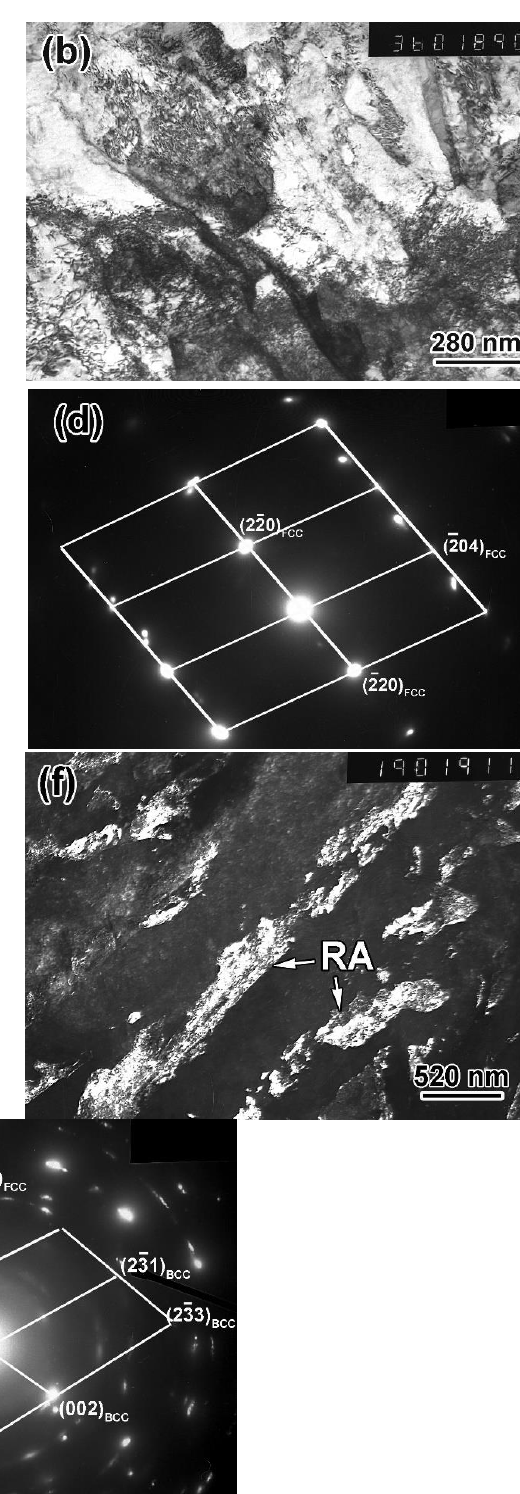
Figure 8. TEM images of the specimens austenitized at 900 °C ( a – d ) and 950 °C ( e – g ). ( a ) Dislocations in ferrite lath, ( b ) bright-field image of ferrite and RA, ( c ) dark-field image of ( b ) in austenite reflection, ( d ) SAED pattern of ( c ) showing the reflection on the [320] zone axis of ferrite and [114] zone axis of austenite, ( e ) bright-field of ferrite and RA, ( f ) dark-field image of ( e ) in austenite reflection, ( g ) SAED pattern of ( f ) showing the reflection on the [221] zone axis of austenite (FCC).